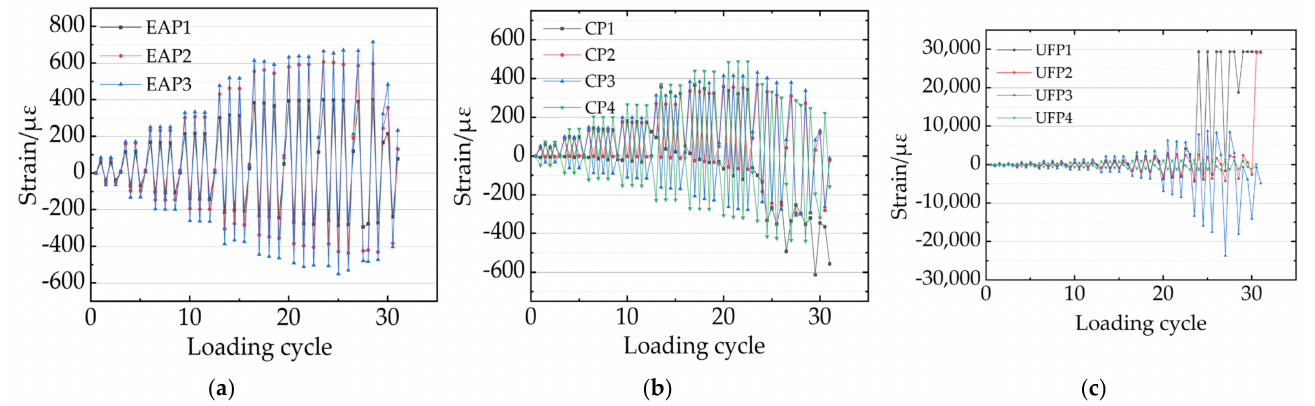
Figure 16. Strain responses of specimen S–CFT–A during loading: ( a ) Strain gauges of series EAP; ( b ) Strain gauges of series CP; ( c ) Strain gauges of series